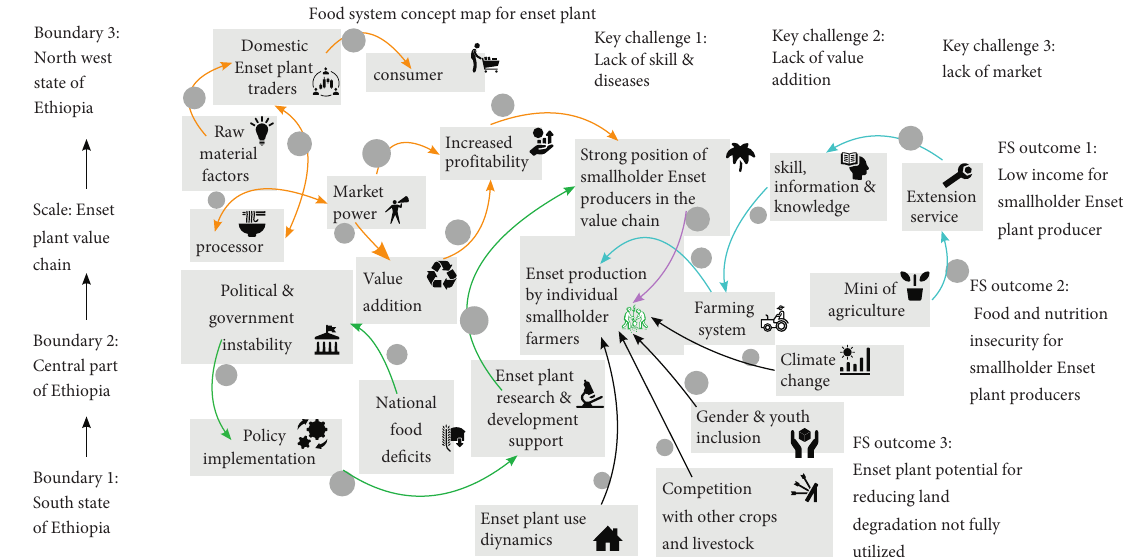
Figure 3: Food system concept for Enset trees. Source: authors own